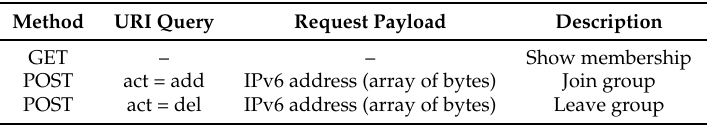
Table 4. The group membership management resource /mc interface.